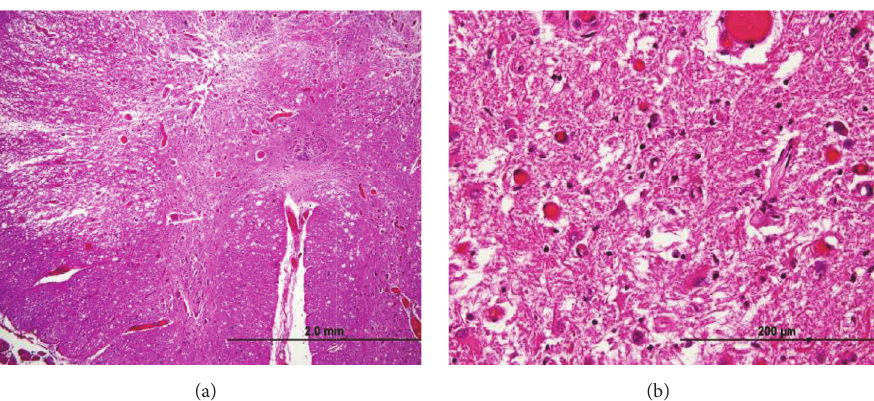
Figure 5: Gray matter damage. (a) Lower-power photomicrograph of gray matter adjacent to ventrolateral tracts (original magnification, × 40; H-E stain); (b) higher-power photomicrograph of adjacent gray matter with neuronal loss and gliosis (original magnification, × 400; H-E